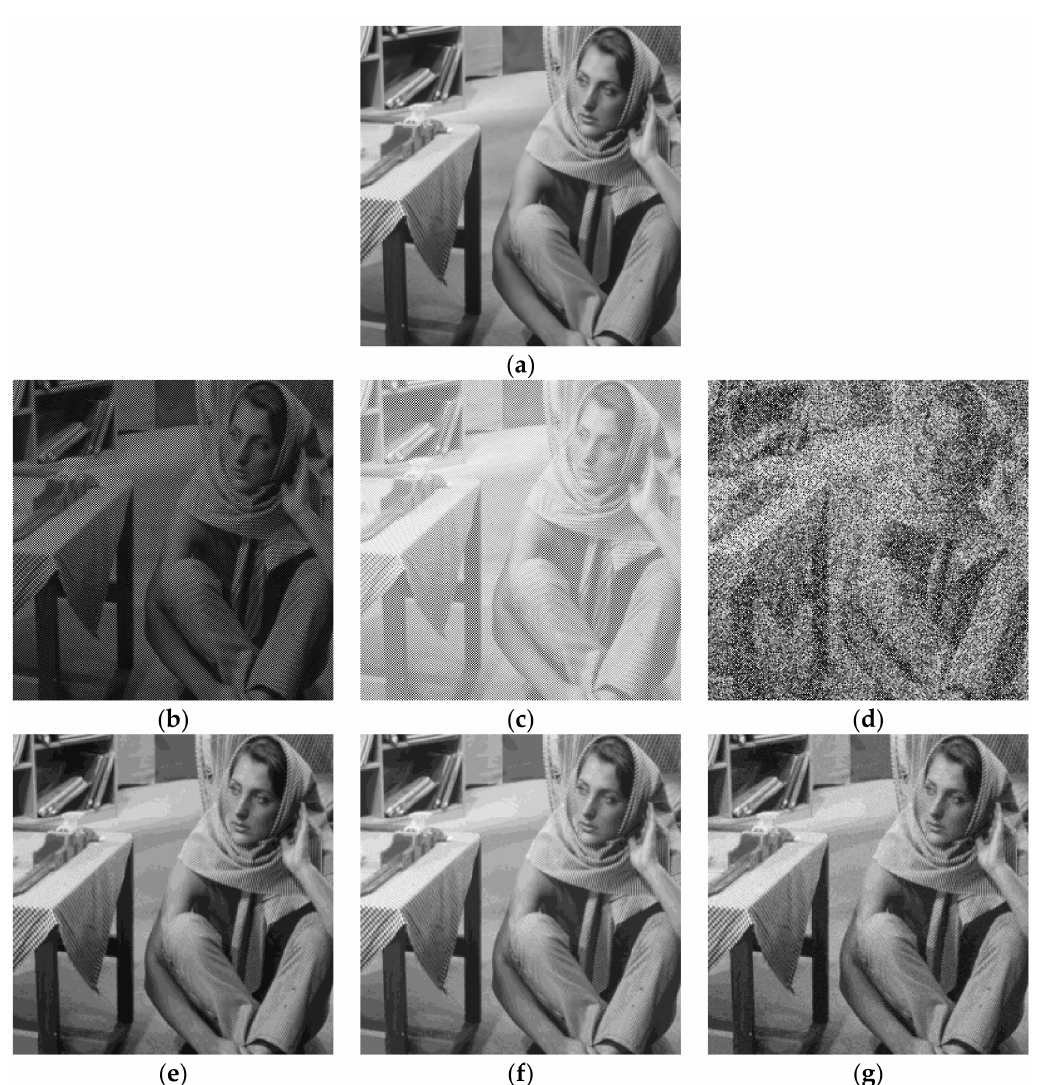
Figure 3. Results of an image by part of group partitions under threshold t = 3, ( a ) the original image: Barbara, ( b – d ) recovery by PS 0 with compensating by 0/1 and random bit, respectively, ( e – g ) recovery by { PS 0 , PS 1 } with compensating by 0/1 and random bit,